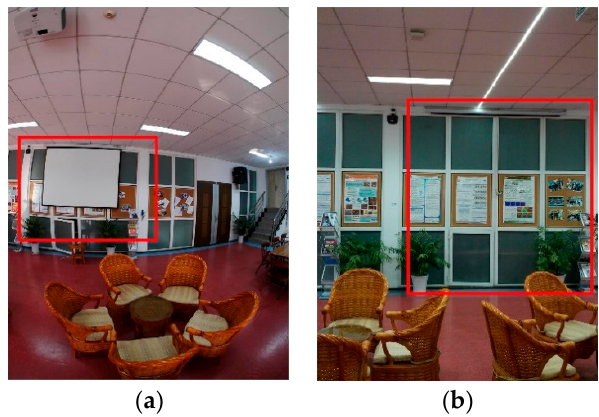
Figure 17. Change of the environment, in the red rectangle. ( a ) Image captured on 4 December 2016. ( b ) Image captured on 16 October 2017.